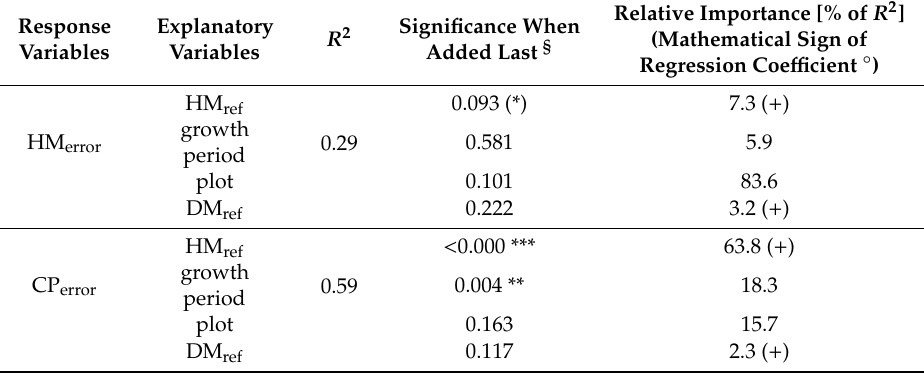
Figure 4. MSI-model versus reference measurements ( n = 147) of HM and CP concentration in herbage. The dashed line is the line of identity (1:1). The open and filled dots represent the two growth stages of the plants: two weeks and four to six weeks of growth. The values of Pearson’s correlation coe ffi cient (r P ) and Lin’s concordance correlation coe ffi cient (CCC) were calculated for values inside the calibration range (HM: n = 98, CP: n = 113). Significance codes: *** ≤ 0.001, ** ≤ 0.01, * ≤ 0.05. Table 3. Linear models that explain errors of the MSI-model in determining fresh HM and CP concentration within the calibration range of the MSI-model (error = | reference − MSI-model | ; HM: n = 98; CP: n = 113).